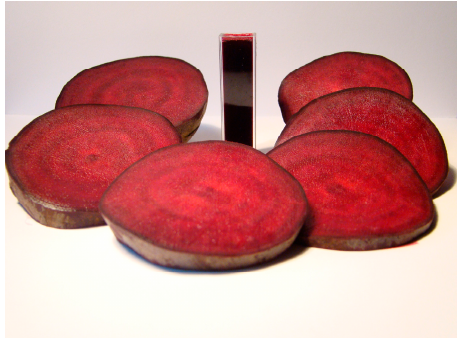
Figure 1. A photograph of a sliced beetroot and beetroot juice.